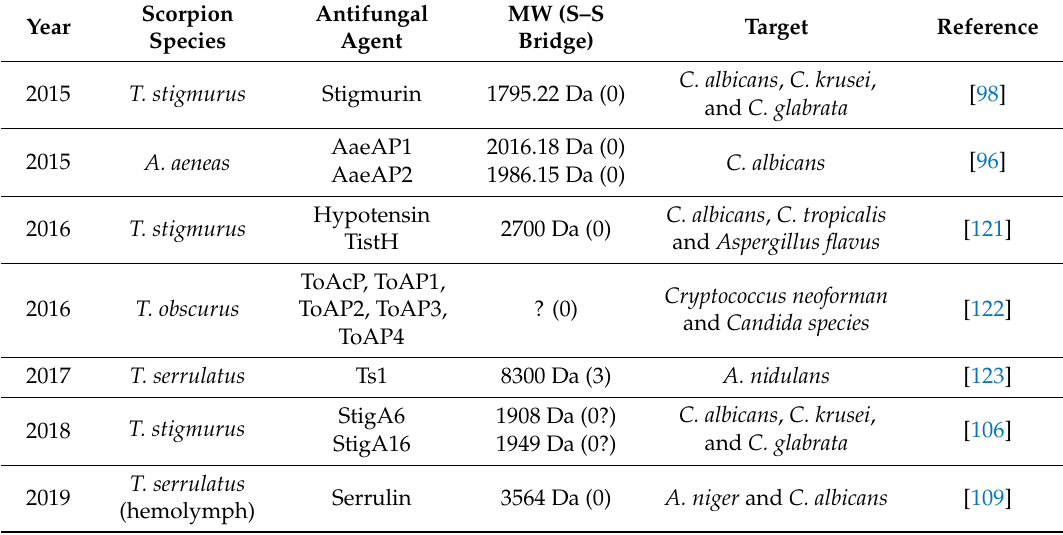
Table 2. Reported work on scorpion derived antifungal